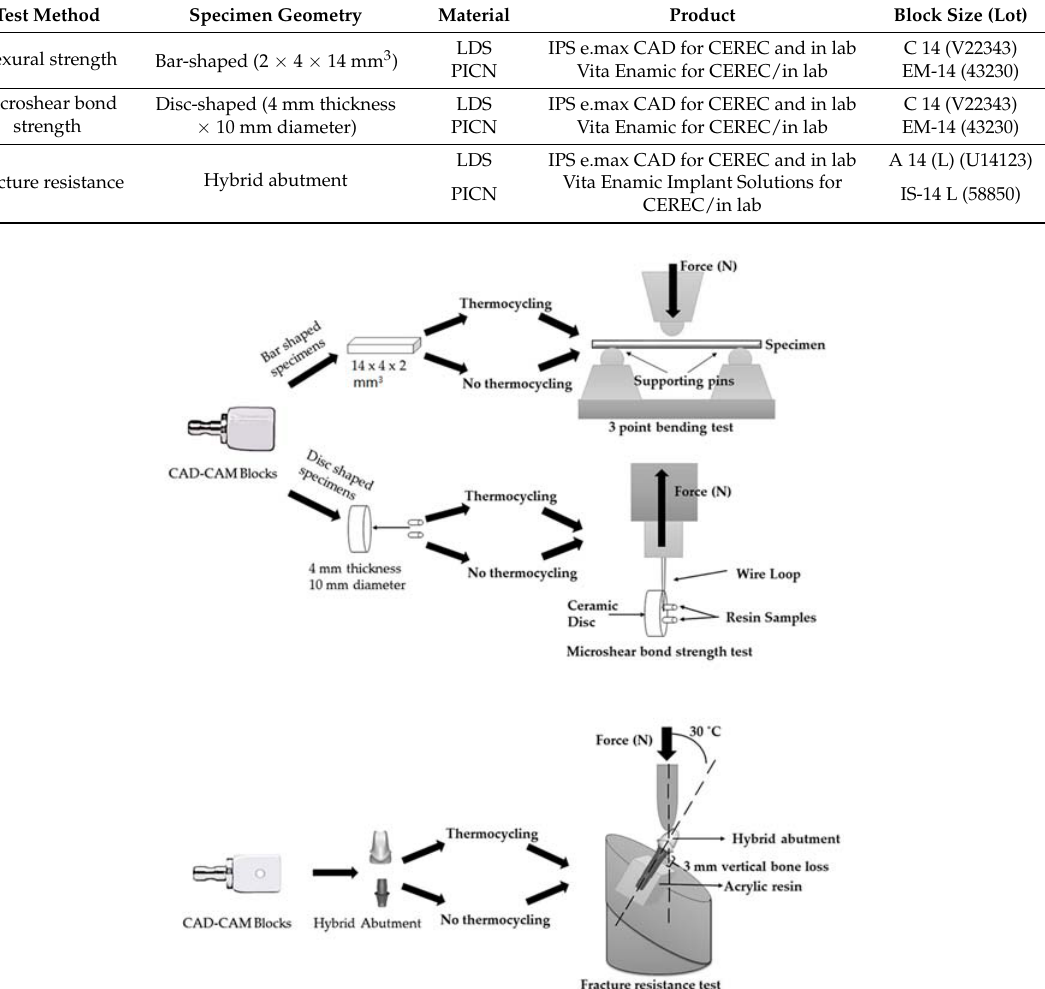
Figure 1. Schematic representation of specimen preparation and test designs. LDS: lithium disilicate ceramic; PICN: polymer-infiltrated ceramic-network; CAD: computer-aided design. For 3-point-bending and µ SBS tests, 20 bar-shaped (1.2 mm × 4 mm × 14 mm) and 20